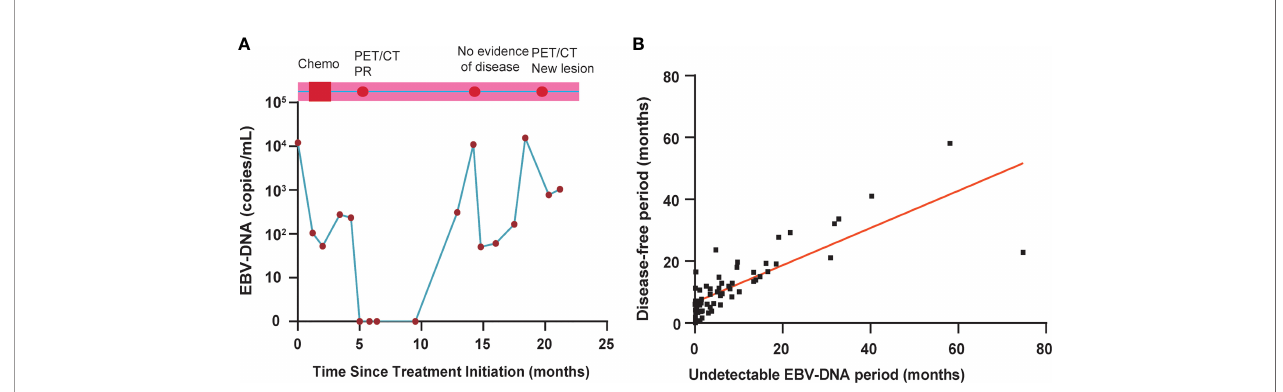
FIGURE 5 | (A) EBV-DNA kinetics and clinical surveillance imaging results for a study patient with a 9-month interval from the fi rst detectable EBV-DNA blood test result and clinical diagnosis of disease progression. PET, positron emission tomography; CT, computed tomography; PR, partial response. (B) Correlation between normalized EBV-DNA period and progression-free survival period in 64 patients with